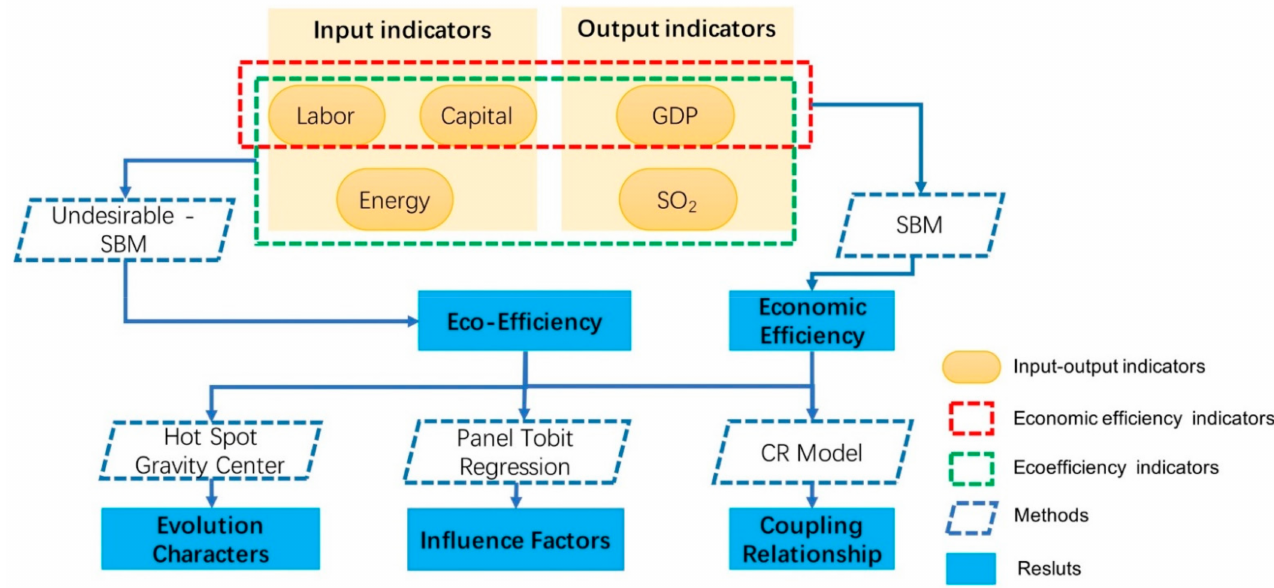
Figure 1. Research